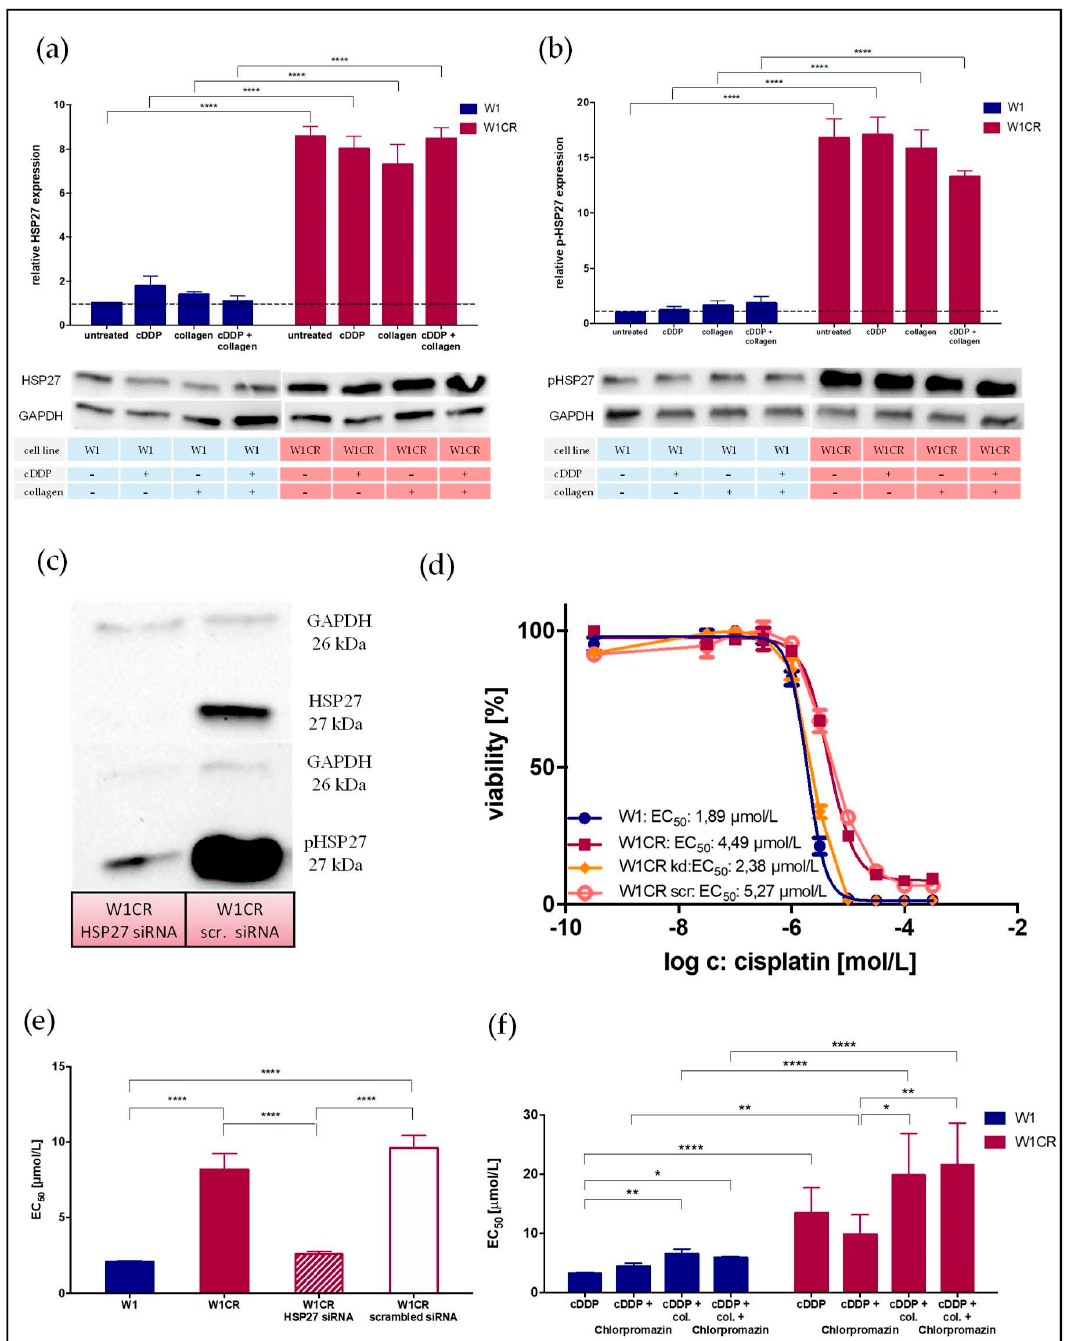
Figure 5. The role of HSP27 in W1CR cell resistance. Detection of protein levels of HSP27 ( a ) and p-HSP27 ( b ) in W1 and W1CR cells upon indicated treatment. ( c ) Knockdown of HSP27 in W1CR cells. Shown is a representative Western blot of HSP27 knockdown in W1CR cells, confirming the almost complete deletion of HSP27 in the knockdown cells compared to scrambled siRNA control. ( d , e ) The W1CR HSP27 knockdown cells display a similar sensitivity to cisplatin cytotoxicity as W1 cells, ( d ) shown in a representative MTT experiment and ( e ) statistically evaluated analyzing the EC50 values compared to the scrambled control cells and to W1CR wild type cells. ( f ) Use of chlorpromazine as an inhibitor of HSP27 confirms that W1 cells were not a ff ected, while W1CR cells were sensitized independent of their COL1 e ff ects. Data are means of at least n = 3 ( ± SEM), asterisks indicate statistical significance: * p < 0.05; ** p < 0.01; **** p <